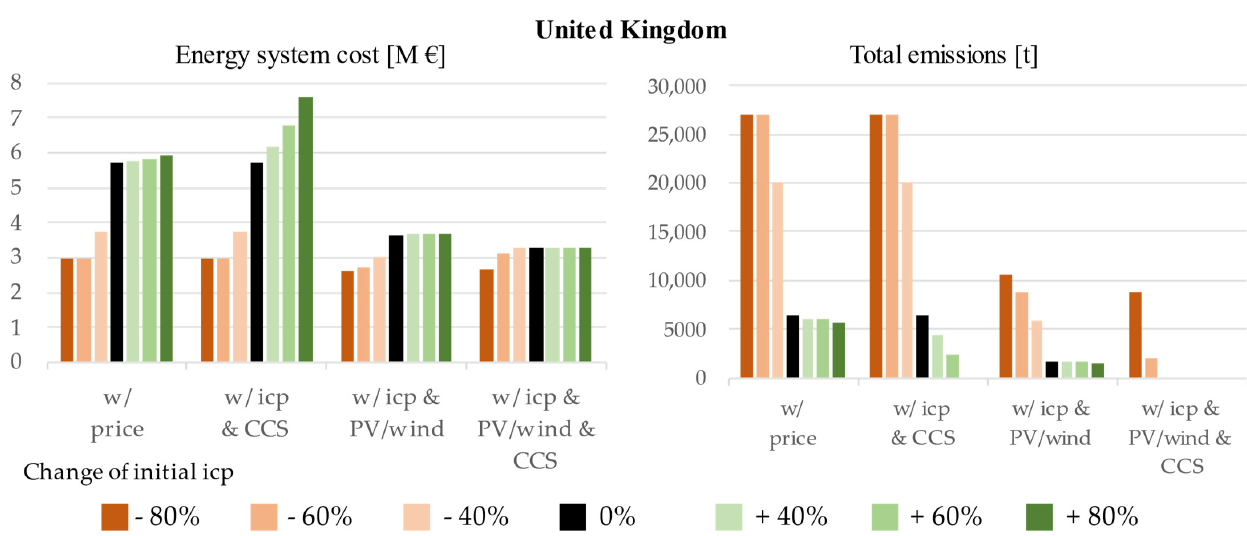
Figure 13. Sensitivity analysis results for the British scenarios.